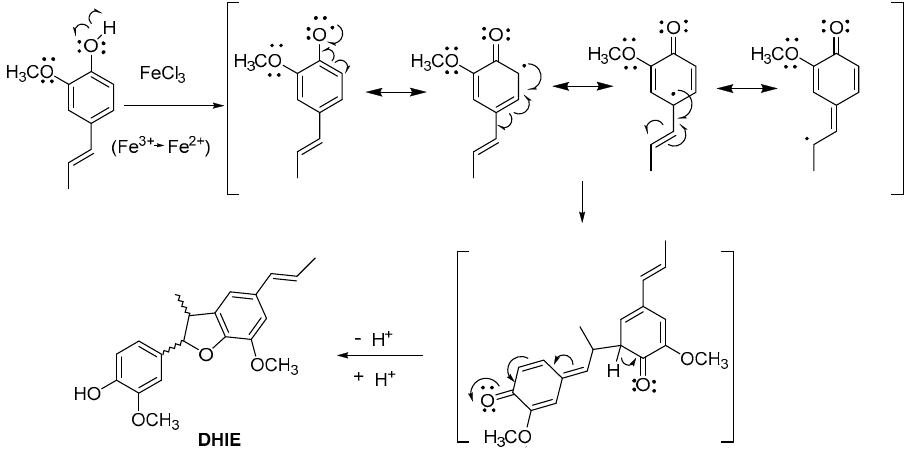
Figure 3. Reaction mechanism for the oxidative dimerization of isoeugenol.